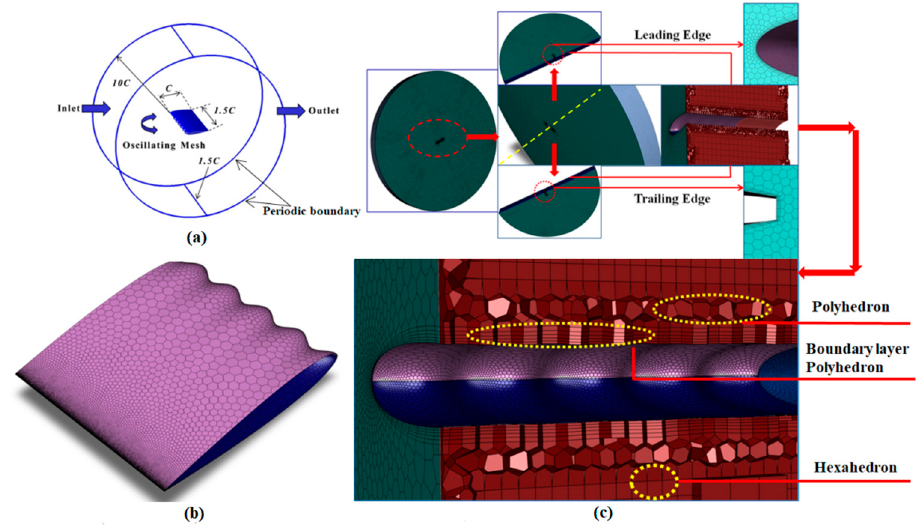
Figure 3. Computational domain and grids. ( a ) calculation domain; ( b ) local schematic of airfoil grid; ( c ) overall schematic of airfoil grid.